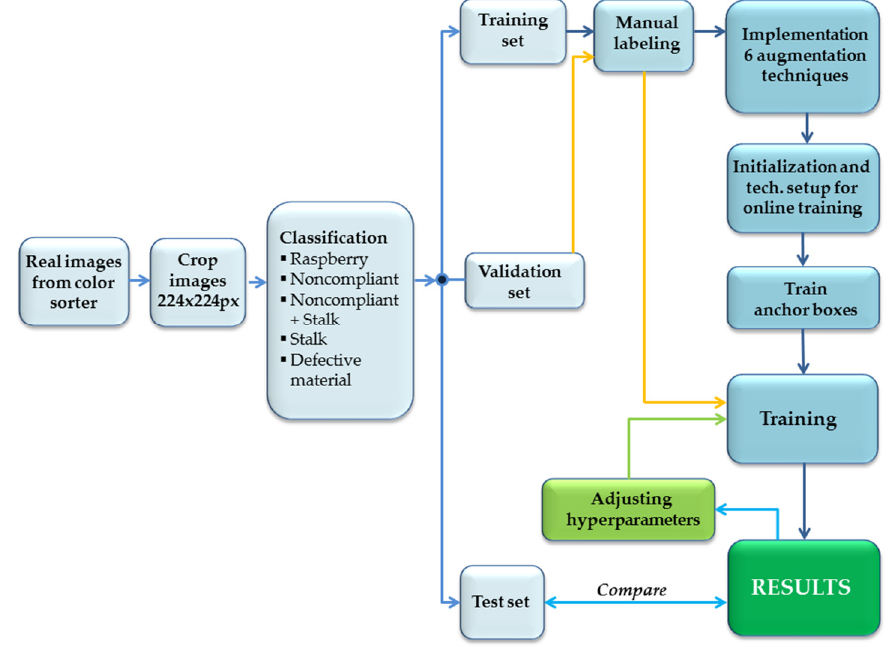
Figure 2. Overview of the performed methods. Training and evaluation pipeline.